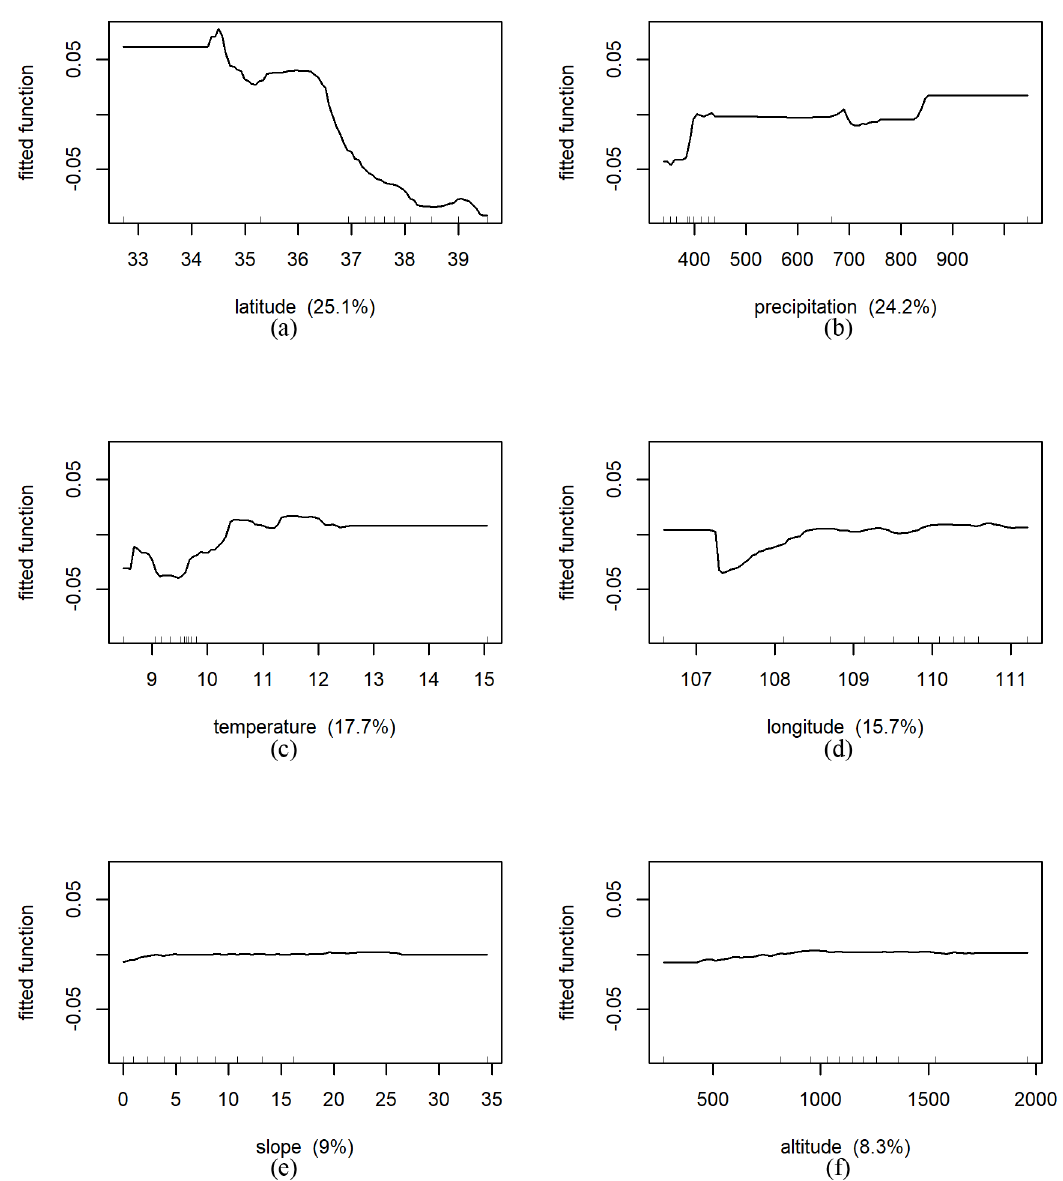
Figure 20. Results of marginal effects of environmental factors on NDVI under grassland in whole Shaanxi Province (The fitted function of NDVI vs. ( a ): latitude (N), ( b ): precipitation (mm), ( c ): temperature ( ◦ C), ( d ): longitude (E), ( e ): slope ( ◦ ), ( f ): altitude (m), respectively. The x -axis denotes the predictive variable; the contents in brackets in the title of the x -axis represent relative influence. The y -axis denotes the marginal effect of the selected variables by “integrating” out the other variables).